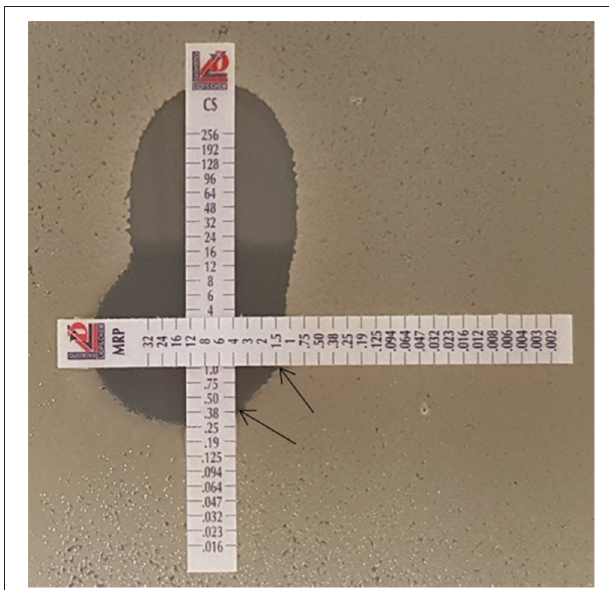
FIGURE 1 | Colistin-meropenem combination using the Etest (90 ◦ ). Etest strip of colistin with either imipenem or meropenem was placed at 90 ◦ crossing at the MIC of the each drug as determined with previous test results. The black arrows indicate the antibiotic concentrations in